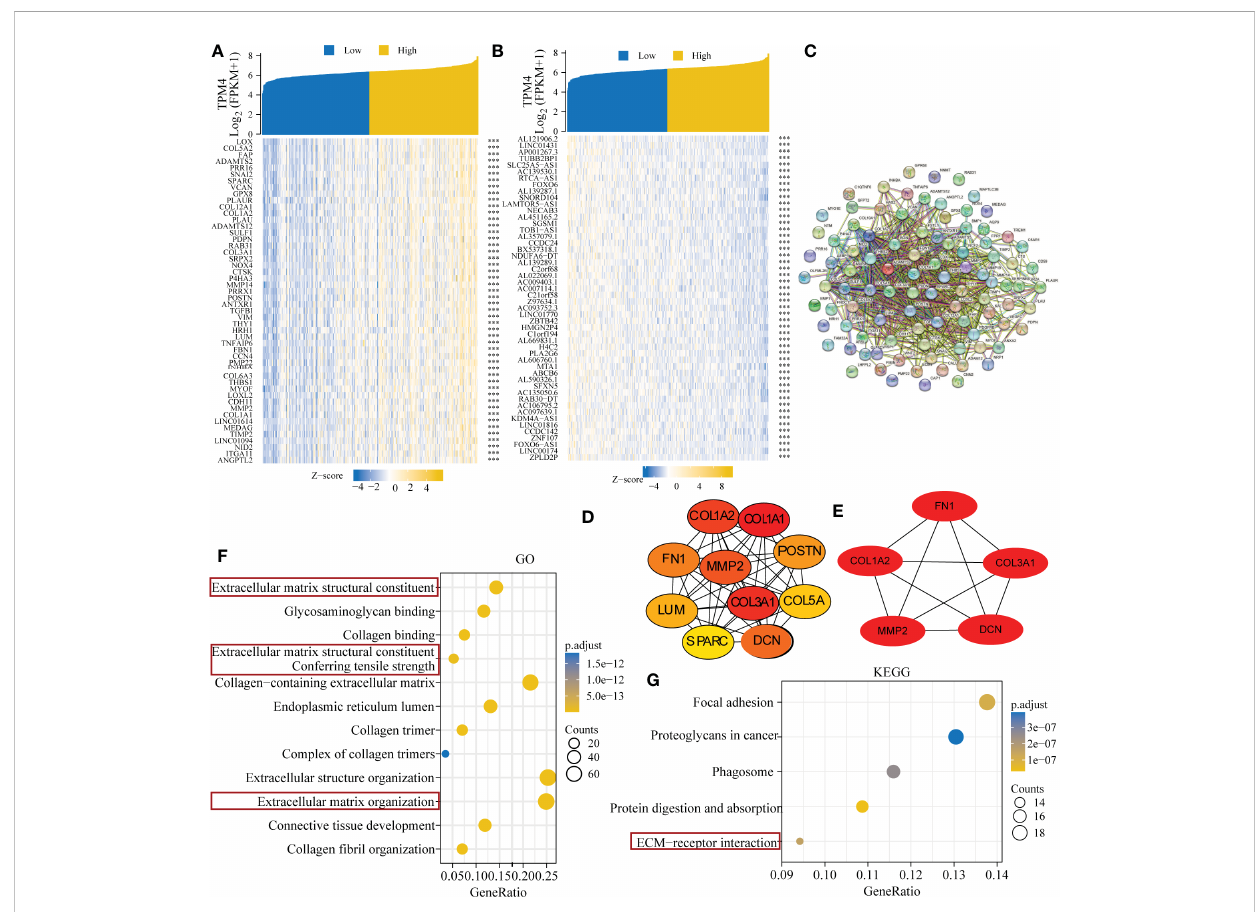
FIGURE 10 Related genes showing co-expression, and functional analysis of TPM4 expression in STAD. (A-B) Expression heatmap of top 50 co-expressed genes positively and negatively correlated with TPM4 expression in STAD. (C) The TOP 100 co-expressed genes positively related to TPM4 expression are shown in the PPI network across STRING. (D, E) The top 10 and top 5 hub genes of the network and the MCODE2 components were identi fi ed. (F, G) Gene Oncology (GO) and Kyoto Encyclopedia of Genes and Genomes (KEGG) analysis of TPM4 and 300 co-expressed genes.